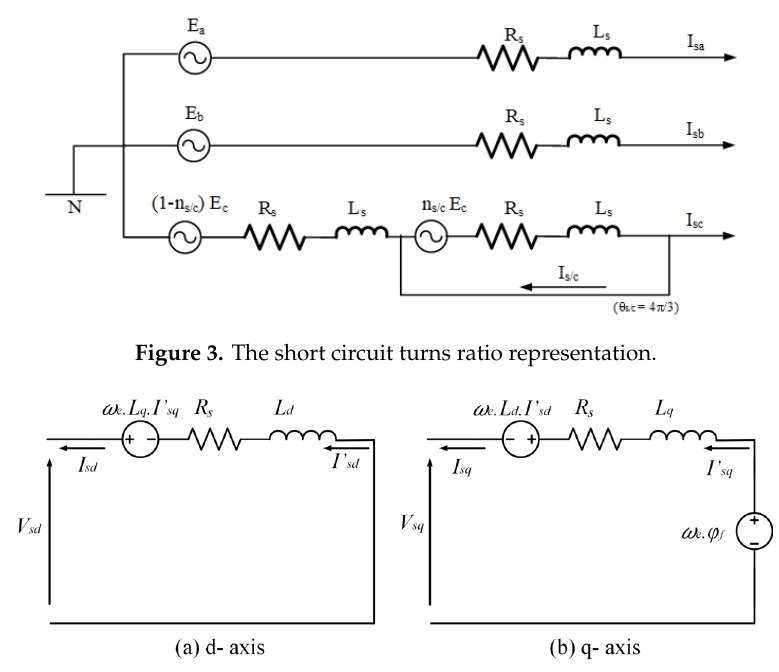
Figure 4. The equivalent circuit of the faulty state PMSG in the dq-frame.